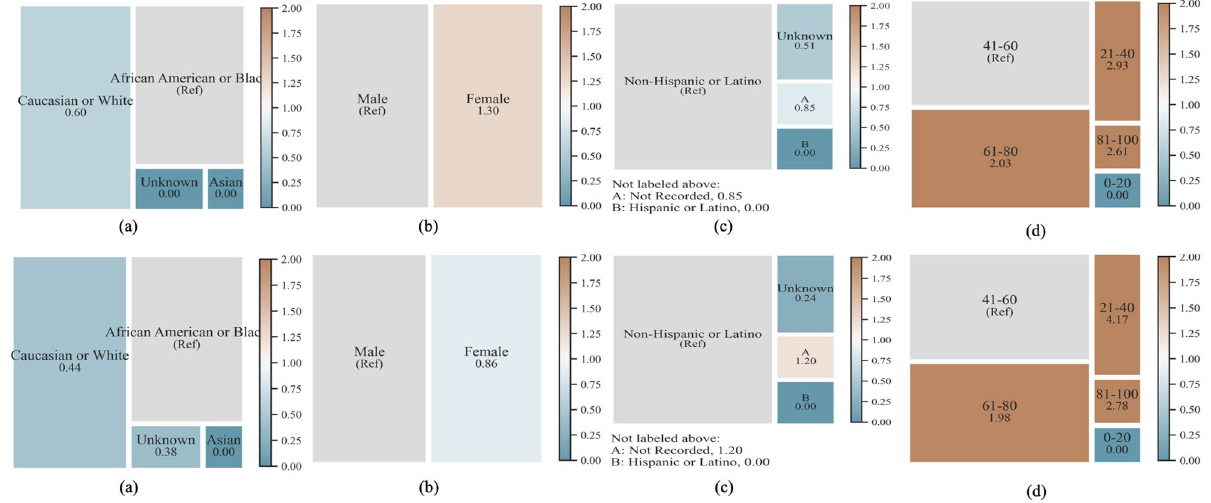
Figure 4. Disparity analysis results in terms of False Negative Rate (FNR) for late fusion using demographic, co-morbidity, and ECG data for different sepsis on-set prediction tasks; (First row) 1 h; (Second row) 4 h; ( a ) Race, ( b ) Gender, ( c ) Ethnic Group, ( d ) Age Category. Ref denotes reference